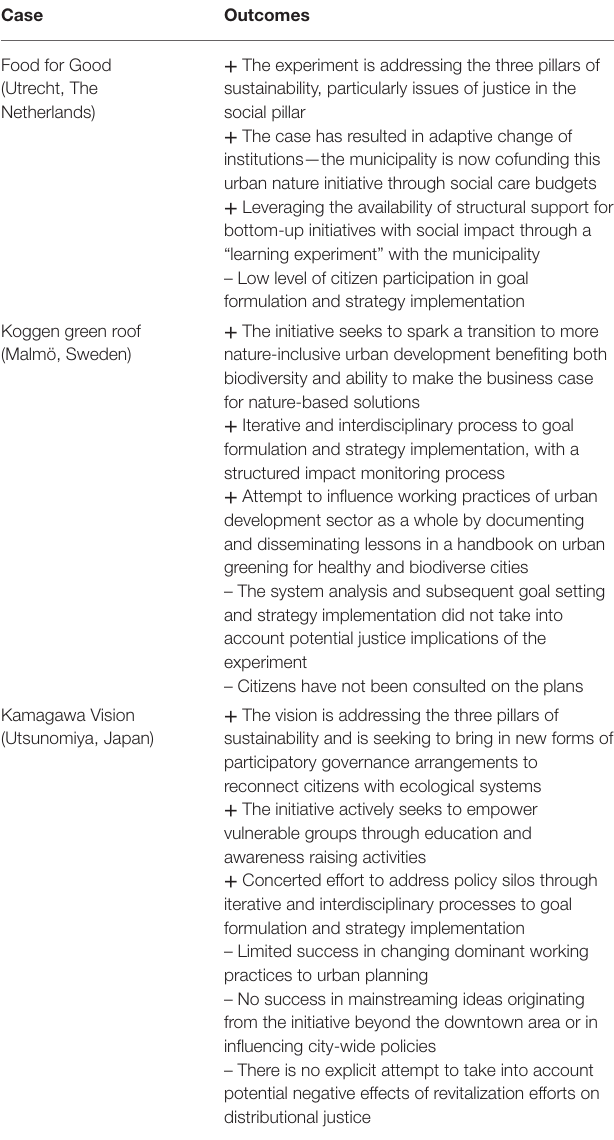
TABLE 2 | Overview showing the main positive ( + ) and negative (–) outcomes of reflexive governance on just and sustainable cities for each of the three studied